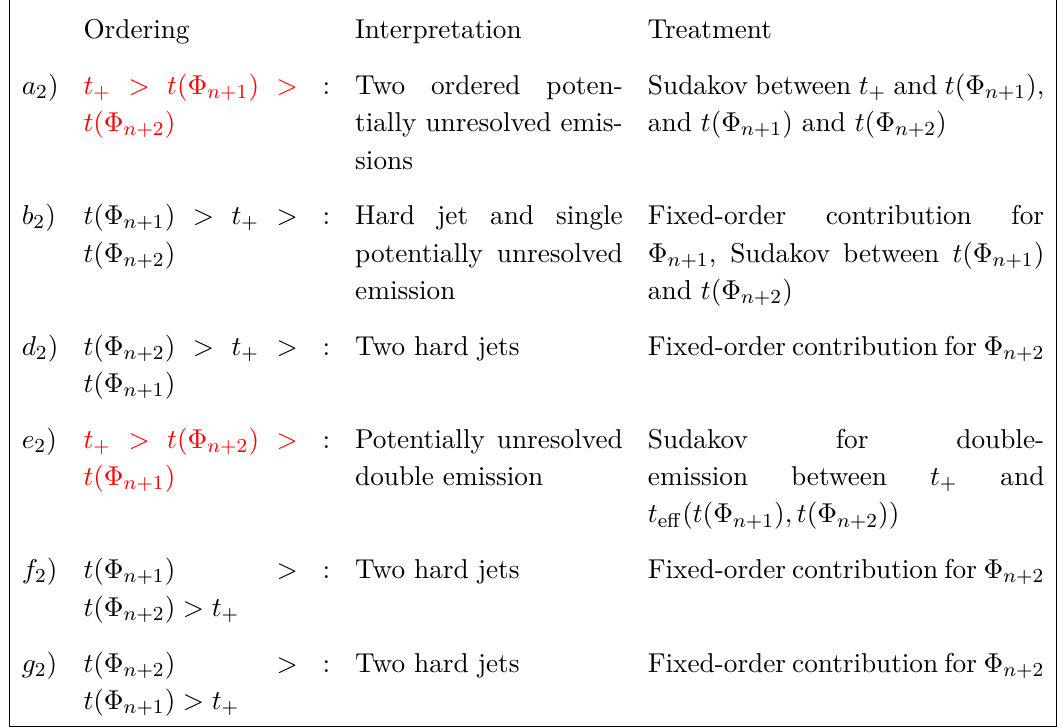
Table 7 . Possible evolution variable orderings for two-parton states. For e + e − → jets, only the ordering sequences in red apply, while any ordering is possible for generic hadron-collider